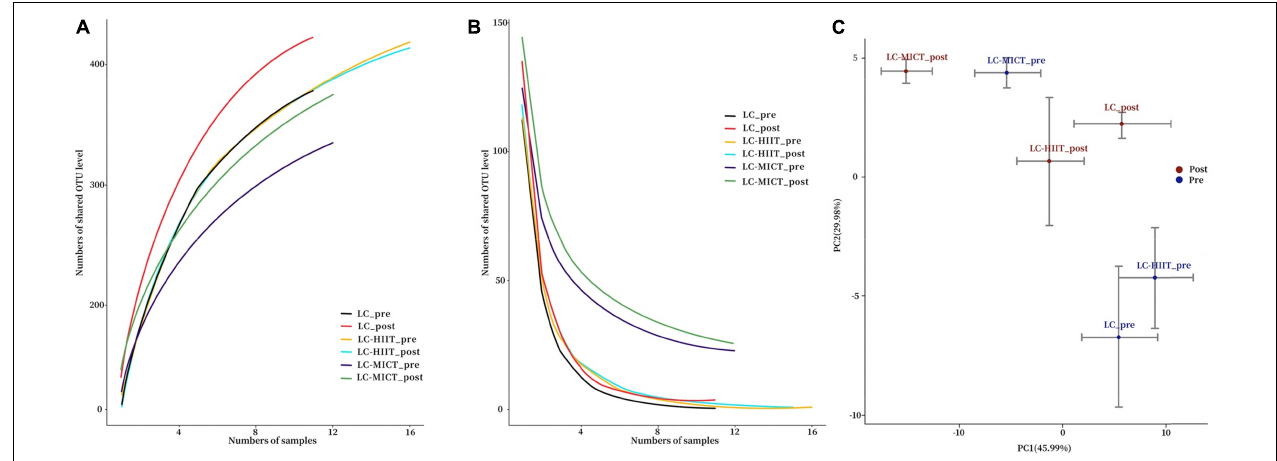
FIGURE 1 | Pan analysis curve (A) , Core analysis curve (B) , and PCA plot of the microbial populations (C) before and after intervention.